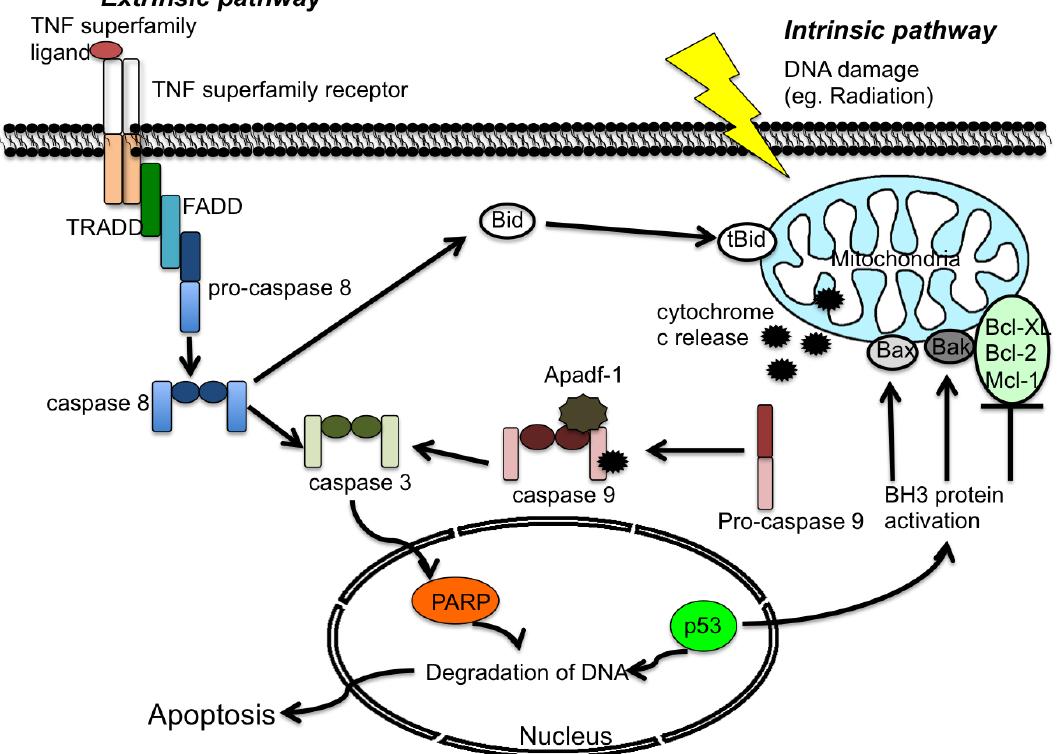
Figure 1. Generalized overview of the extrinsic and intrinsic apoptosis